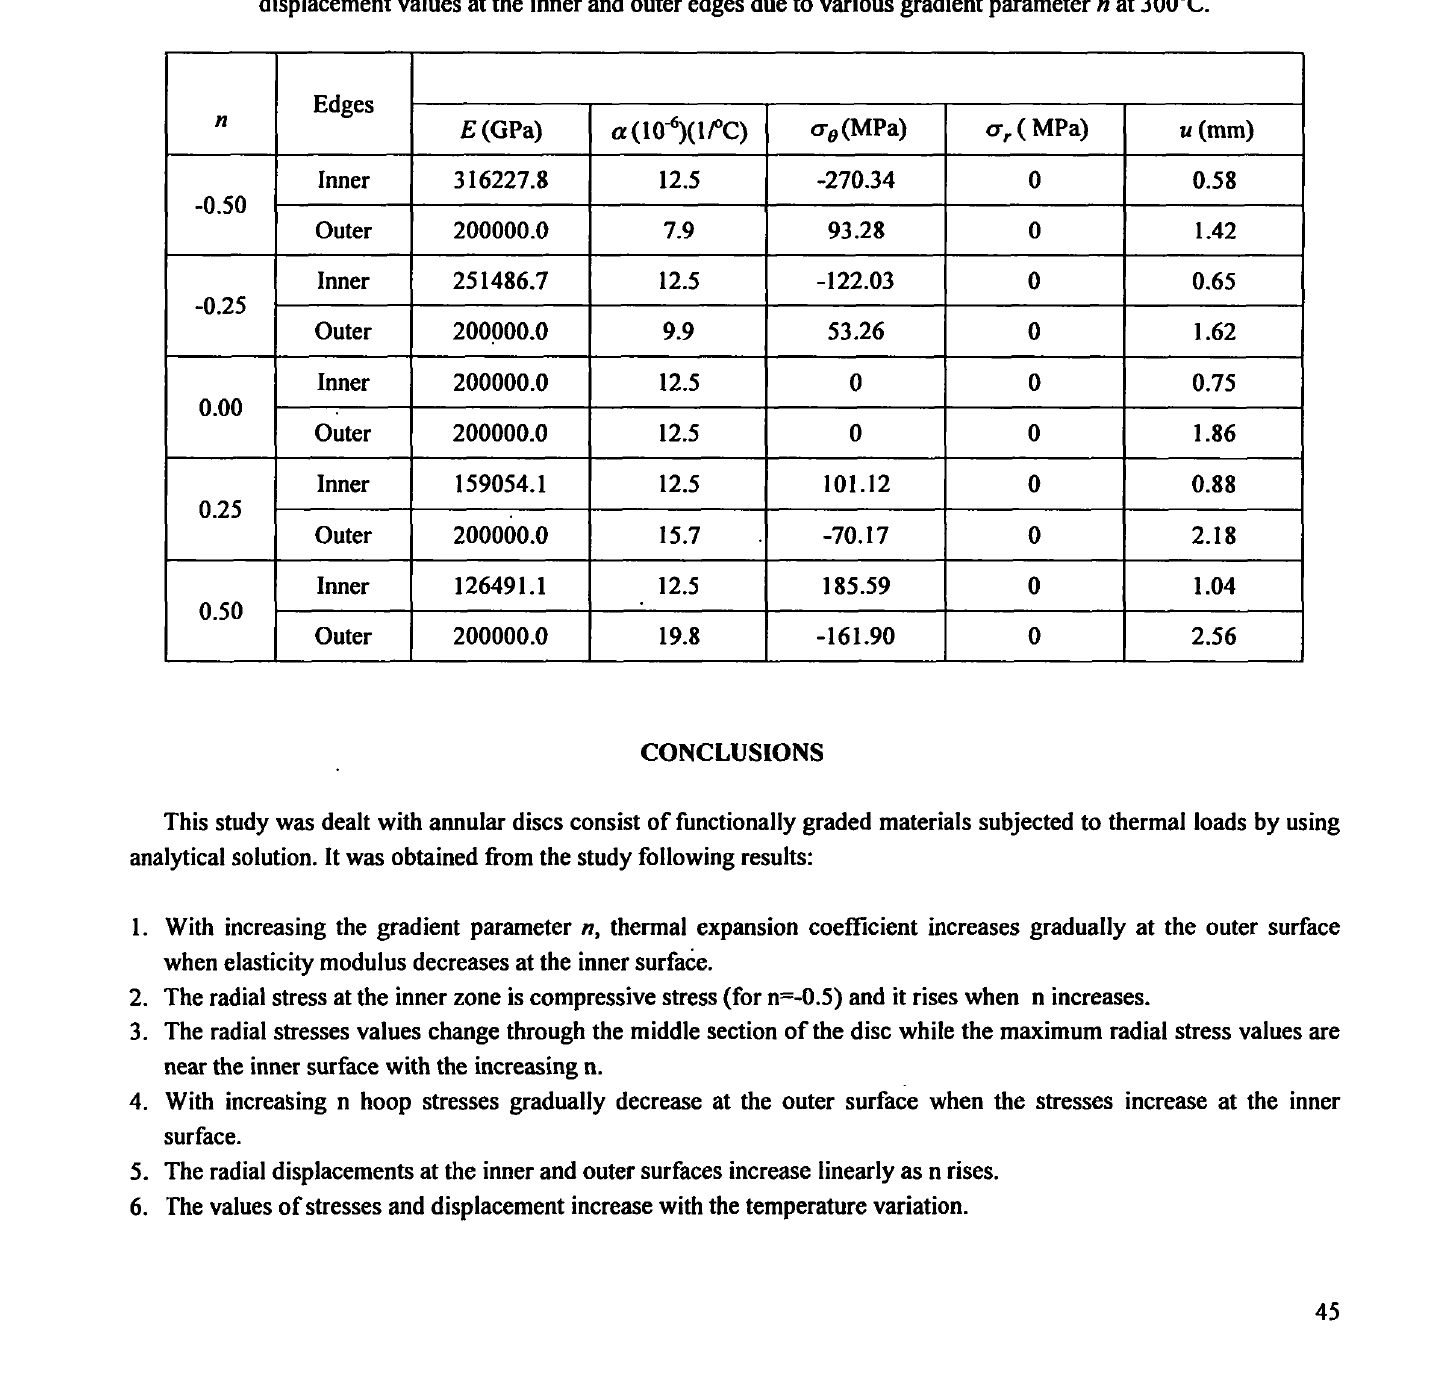
The elasticity modulus, thermal expansion coefficient, stresses and displacement values at the inner and outer edges due to various gradient parameter n at